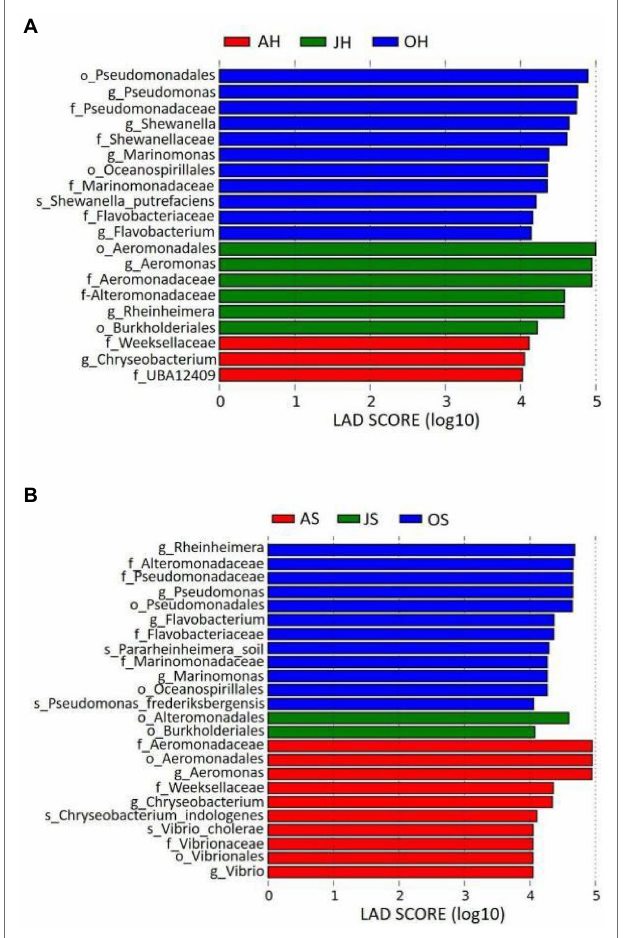
FIGURE 5 | Taxonomic differences among epiphytic bacteria in M. spicatum from Baiyangdian Lake in June, August, and October by a linear discriminant analysis (LDA). (A) M. spicatum obtained from Shihoudian Lake, and (B) M. spicatum obtained from Damaidian Lake.